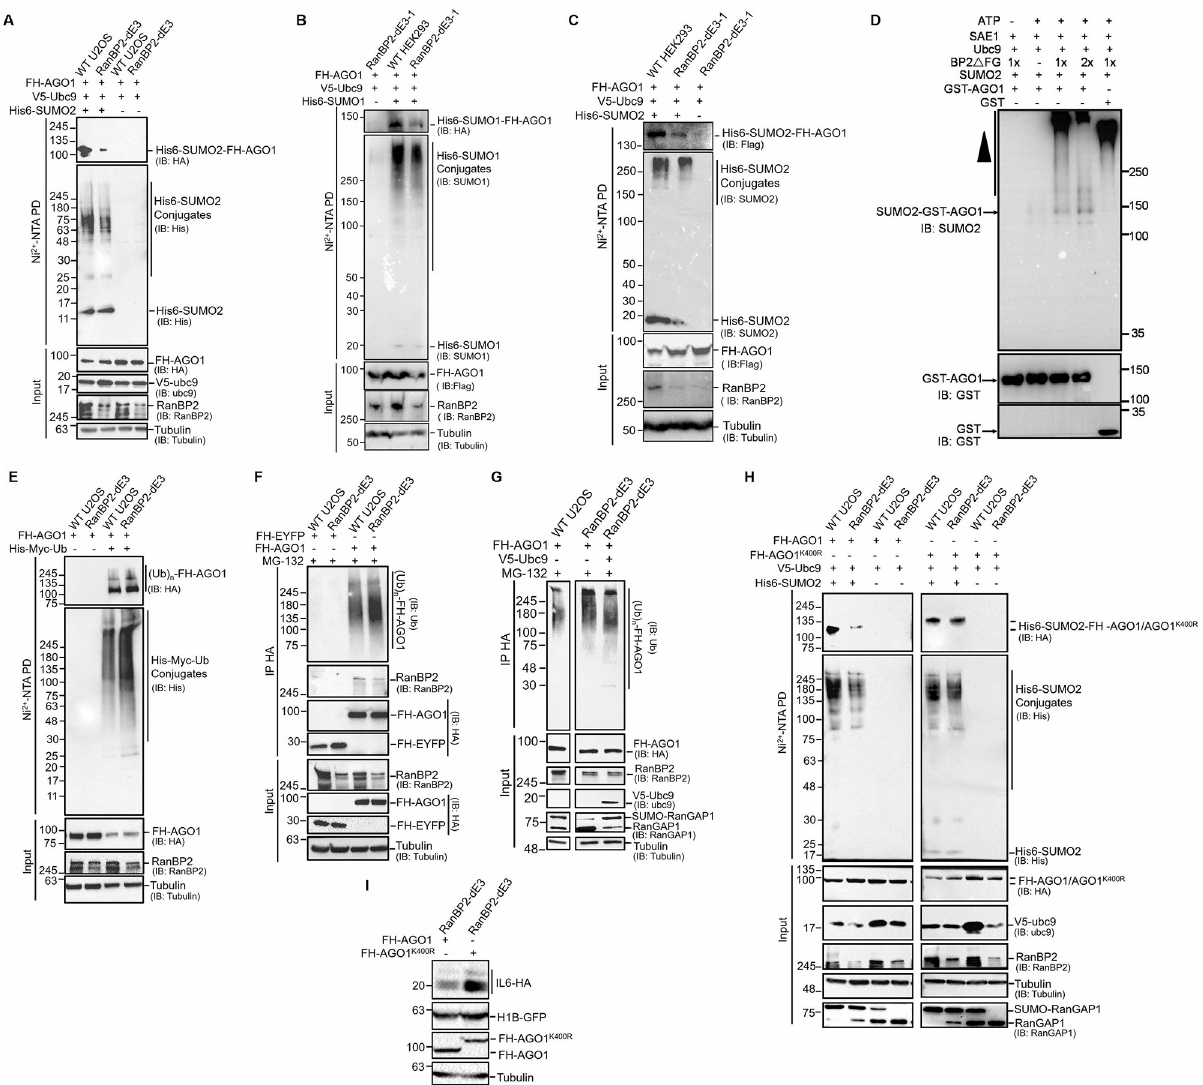
Fig 7. RanBP2 promotes the sumoylation and inhibits the ubiquitination of AGO1. (A) Unmodified and RanBP2-dE3 U2OS cells were co- transfected with plasmids expressing Flag-HA-tagged AGO1 ( FH-AGO1 ), SV5-tagged Ubc9 ( V5-Ubc9 ), and His-tagged SUMO2 ( His6-SUMO2 “+”) or control vector ( His6-SUMO2 “-”). 24 h post-transfection cells were lysed in 6 M Guanidinium-HCl, and the His6-SUMO2 conjugates were isolated on Nickel beads (“Ni 2+ NTA PD”) or the lysates were directly analyzed (“input”) and separated by SDS-PAGE. Conjugates were analyzed for the presence of FH-AGO1 by immunoblotting for HA (IB: HA), and for total His6-SUMO2 conjugates by immunoblotting for His (IB: His). Input lysates were immunoblotted with antibodies against FH-AGO1, V5-Ubc9, RanBP2 and α -tubulin. See S10A Fig for the quantification of His6-SUMO2-FH-AGO1 levels. (B-C) As in (A), except that unmodified and RanBP2-dE3-1 HEK293 cells were transfected with His6-SUMO1 (B) or His6-SUMO2 (C). Antibodies used for immunoblotting were as indicated on the right. See S10B and S10C Fig for the quantification of His6-SUMO1-FH-AGO1 and His6-SUMO2-FH-AGO1 levels. (D) AGO1 was in vitro sumoylated with purified components, with SUMO2, active recombinant human RanBP2 protein (BP2 Δ FG) as the SUMO E3-ligase, and recombinant GST-tagged human AGO1 protein (GST-AGO1) or GST as substrates. Equal amounts of SAE1, SUMO2, Ubc9, GST-AGO1 and GST (35 ng) were added to 10 μ L reactions, where 1x is estimated to be 5 ng of BP2 Δ FG. Negative controls lacking ATP or BP2 Δ FG were also shown. After incubation at 30˚C for 1 h, the reactions were analyzed by immunoblotting with antibodies indicated. The position of SUMO2-modified AGO1 is indicated and the SUMO2-conjugated BP2 Δ FG is represented by the arrowhead. (E) Similar to (A), except that U2OS cells were co-transfected with plasmids for FH-AGO1 , and His-Myc-tagged ubiquitin ( His-Myc-Ub “+”) or control vector ( His-Myc-Ub “-”). 18 h post-transfection, cells were treated with MG132 (10 μ M) for an additional 7 h to preserve ubiquitinated conjugates. Cells were lysed in 6 M Guanidinium-HCl, and the His-Myc-Ub conjugates were isolated on Nickel beads (“Ni 2+ NTA PD”) or the lysates were directly analyzed (“input”) and separated by SDS-PAGE. Conjugates were analyzed for the presence of FH-AGO1 by immunoblotting for HA (IB: HA), and for total His-Myc-Ub conjugates by immunoblotting for His (IB: His). See S10D Fig for the quantification of His-Myc-Ub-FH-AGO1 levels. (F) Unmodified and RanBP2-dE3 U2OS cells were transfected with plasmids for FH-AGO1 or Flag-HA-tagged yellow fluorescent protein ( FH-EYFP ). 18 h post- transfection, cells were treated with MG132 (10 μ M) for an additional 7 h to preserve ubiquitinated conjugates. Cells were lysed in RIPA buffer, and